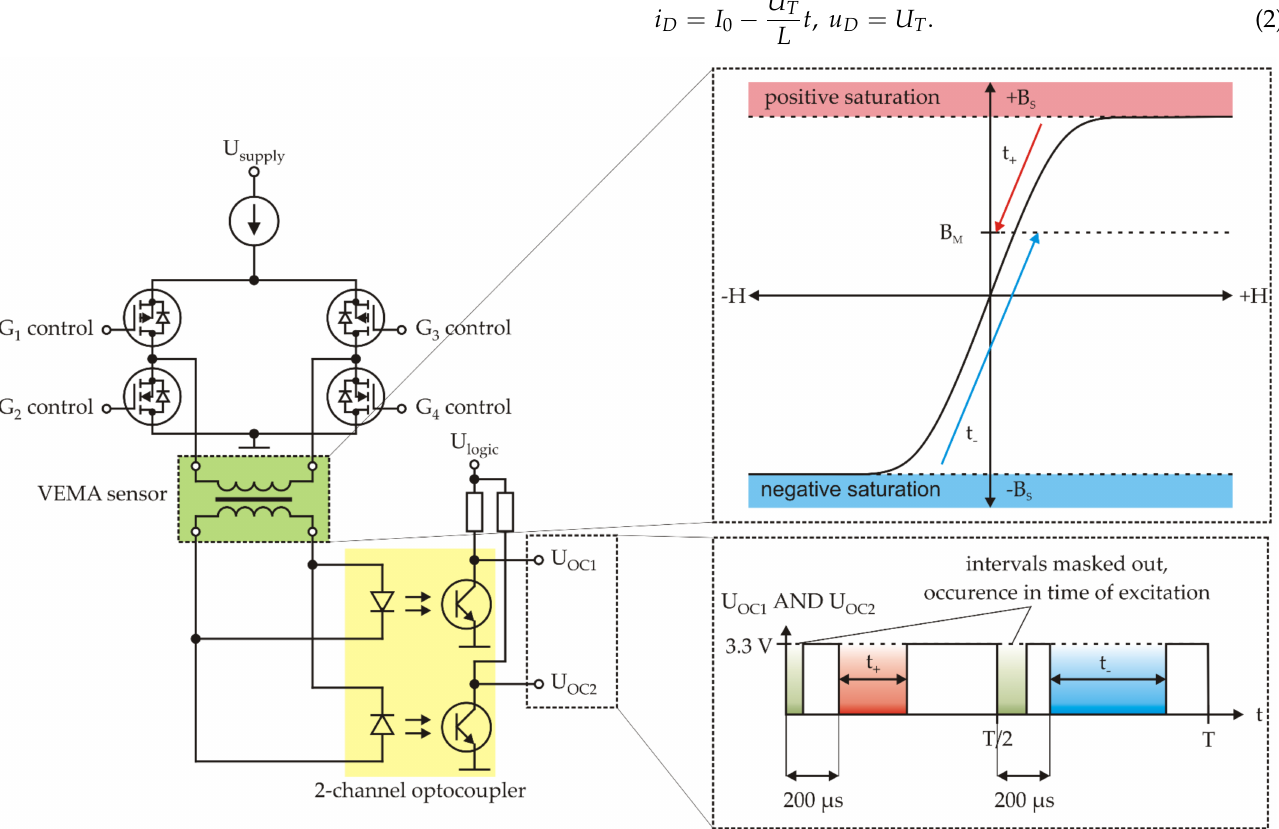
Figure 5. Three-state current source and evaluated signals. The gates of the bridge are controlled by the small FPGA (Field Programmable Logic